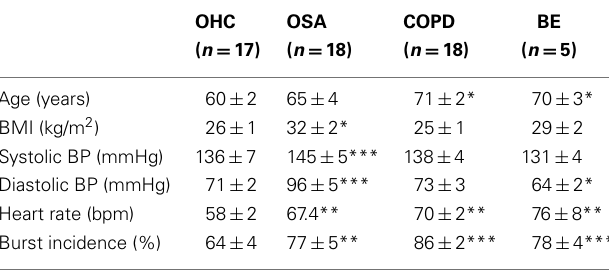
Table 1 | Clinical details of the patients with obstructive sleep apnea (OSA; Elam et al., 2002), obstructive pulmonary disease